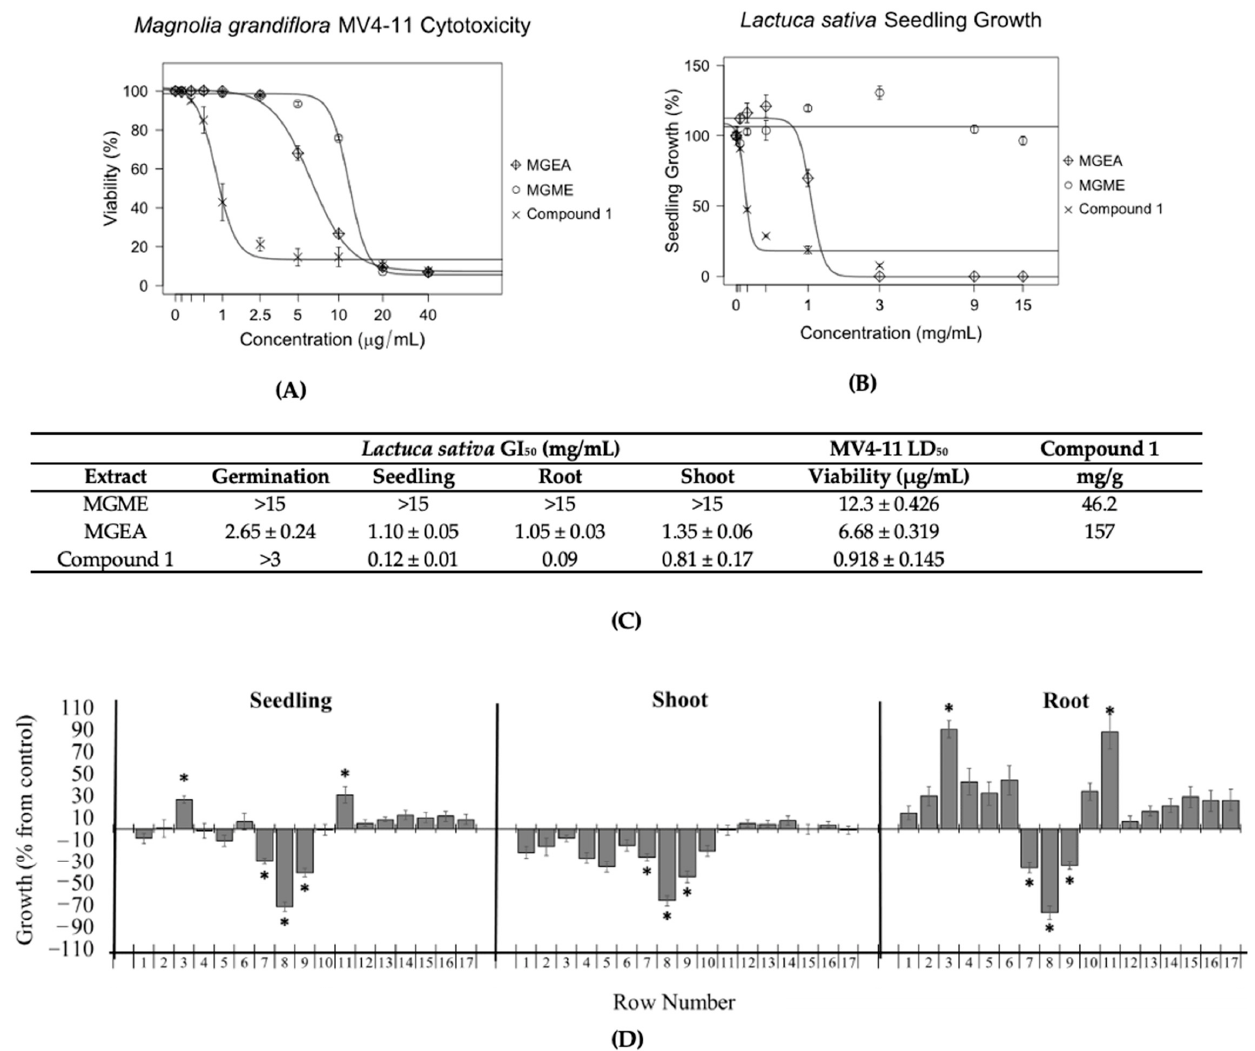
Figure 2. The inhibitory effects on seedlings by Magnolia grandiflora extracts ( A ) and their MV4-11 cytotoxicity ( B ) correlated with the concentration of compound 1 . ( C ) GI 50 and LD 50 values correlated with the concentration of compound 1 in the extracts. The bioautography assay ( D ) confirmed that compound 1 was the major inhibitory component. ( A ) Inhibitory effects of M. grandiflora ethyl acetate (MGEA) and methanolic (MGME) extracts on the seedlings of L. sativa . Experiments were performed in triplicate. ( B ) Concentration–response curves of MGEA and MGME extracts against MV4-11 cell lines after 48 h of incubation. Experiments were performed in duplicate, and parthenolide (compound 1 ) was used as a positive control. ( C ) Extract and compound 1 GI 50 values for L. sativa and LD 50 values for MV4-11, as well as the ratio (mg/g) of compound 1 in extracts. ( D ) Bioautography assay of MGEA extract on the growth of L. sativa . Growth is expressed as the % difference from the control value, and the chromatographic bands are divided by 1 cm rows from the application point to the elution limit on the TLC plate (1–17). * The level of significance was p ≤ 0.05. Row 8 was identified as compound 1 . All data are presented as the mean ±